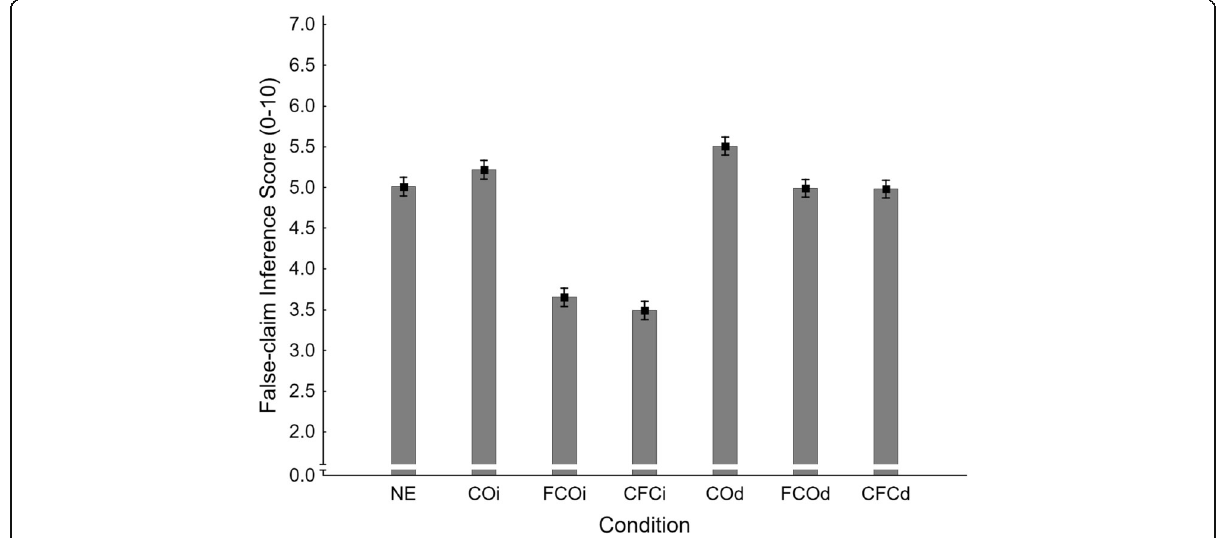
Fig. 7 Mean false-claim inference scores across conditions NE (no-exposure), COi/d (claim-only, immediate/delayed test), FCOi/d (fact-check-only, immediate/delayed test), and CFCi/d (claim-plus-fact-check, immediate/delayed test) in Experiment 2. Error bars show standard errors of the